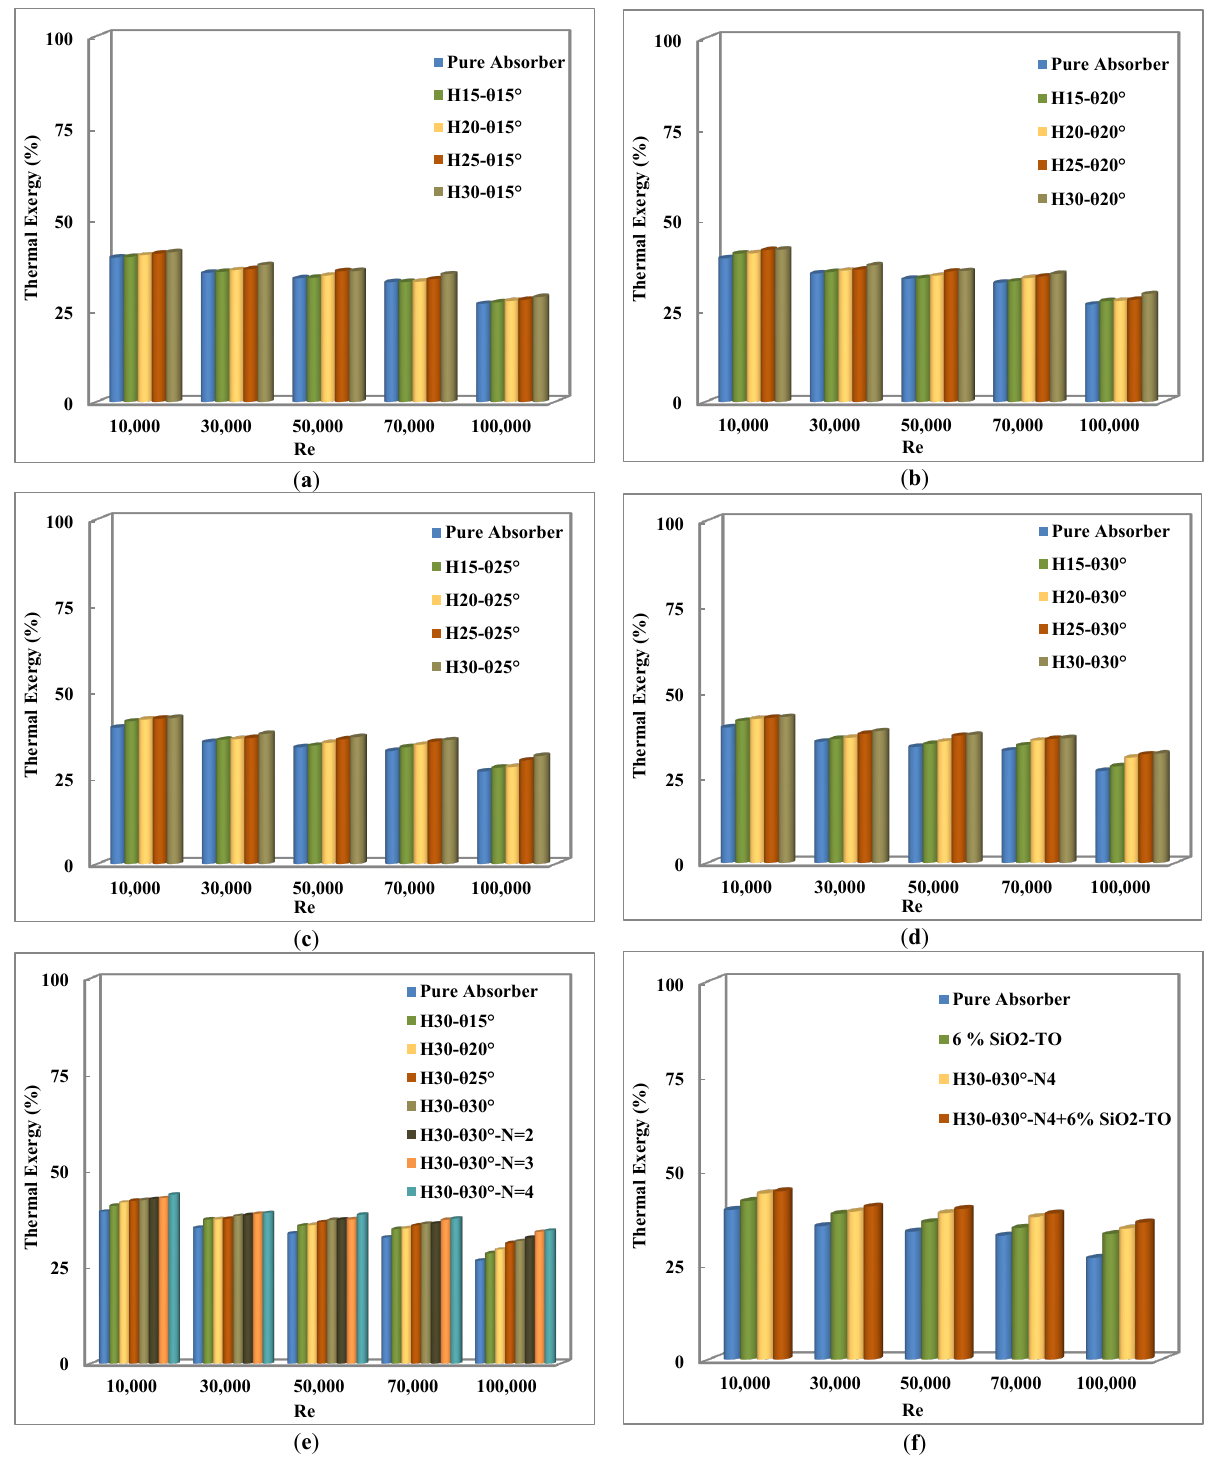
Figure 19. Comparison of thermal exergy efficiency for all considered cases. ( a ) Pitch height variation with θ = 15°, ( b ) Pitch height variation with θ = 20°, ( c ) Pitch height variation with θ = 25°, ( d ) Pitch height variation with θ = 30°, ( e ) Pitch angle ( θ ) and number of inserts (N) variation with fixed pitch height, ( f ) Optimal configuration with and without nanofluids.